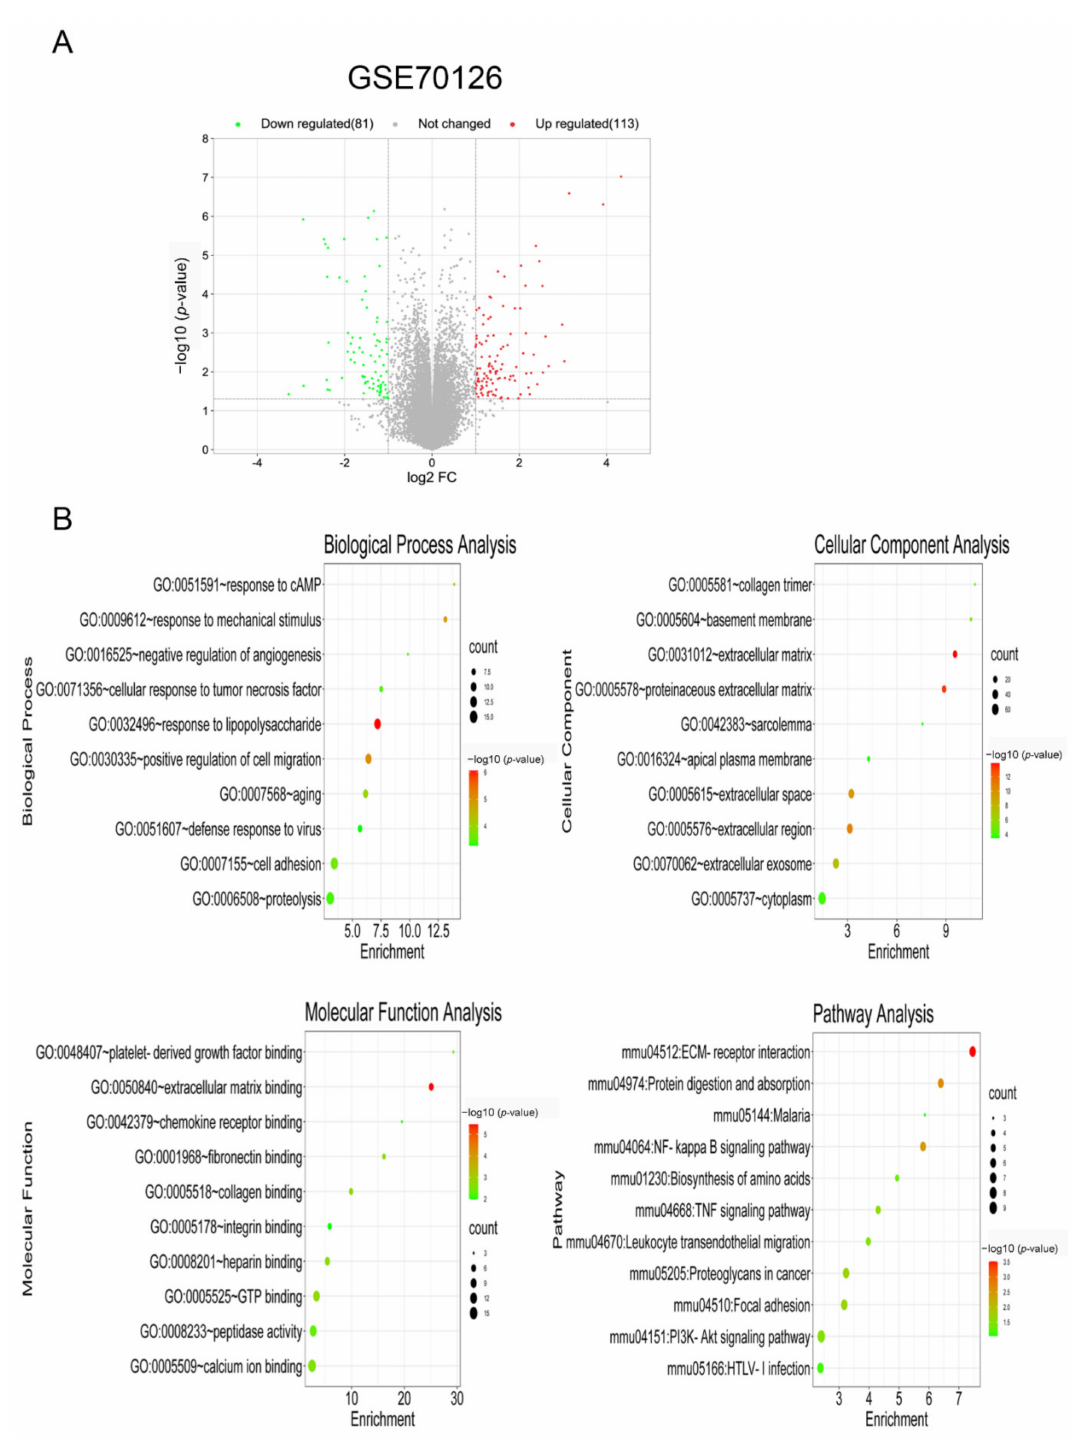
Figure 1. Identification and enrichment analysis of DEGs in foam cells. ( A ) Volcano plot of gene expression profile data between foam cells and macrophages in GSE70126. ( B ) Functional and signaling pathway analysis of DEGs between foam cells and